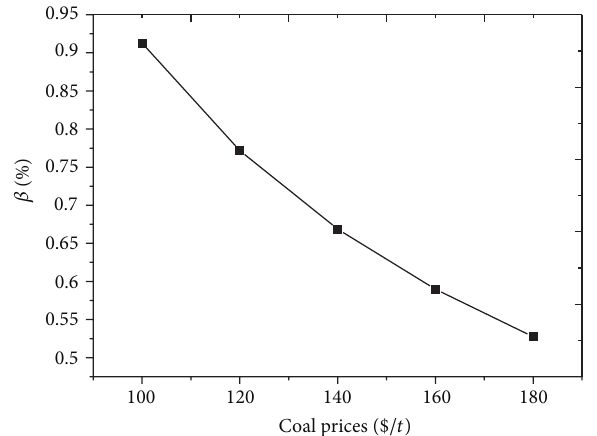
Figure 8: The change of the overall cost proportion of solar with the solar facilities’